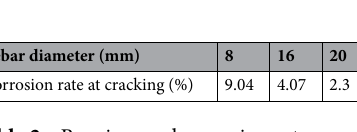
Table 2. Bar sizes and corrosion